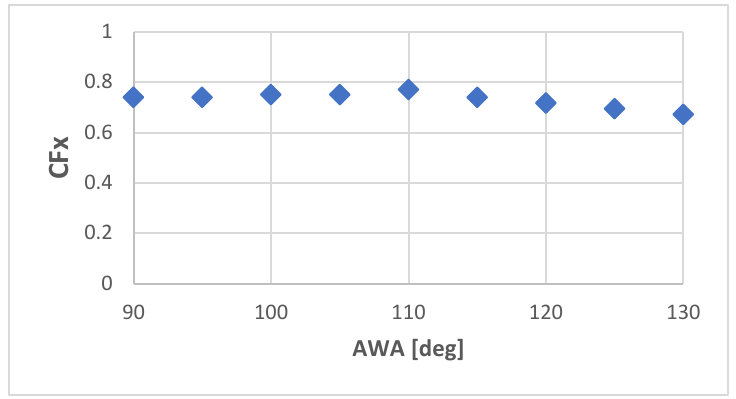
Figure 21. Drive force coefficients calculated with the numerical proposed method.